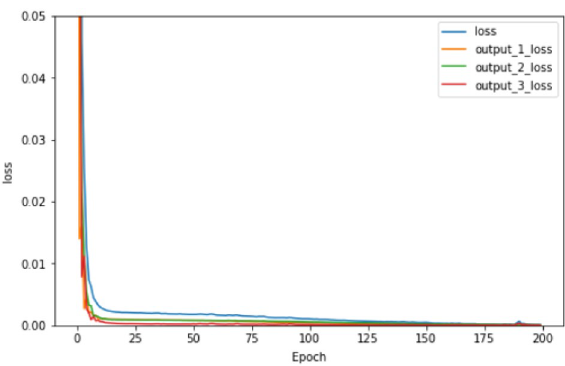
Figure 10. The variation curves of loss values.